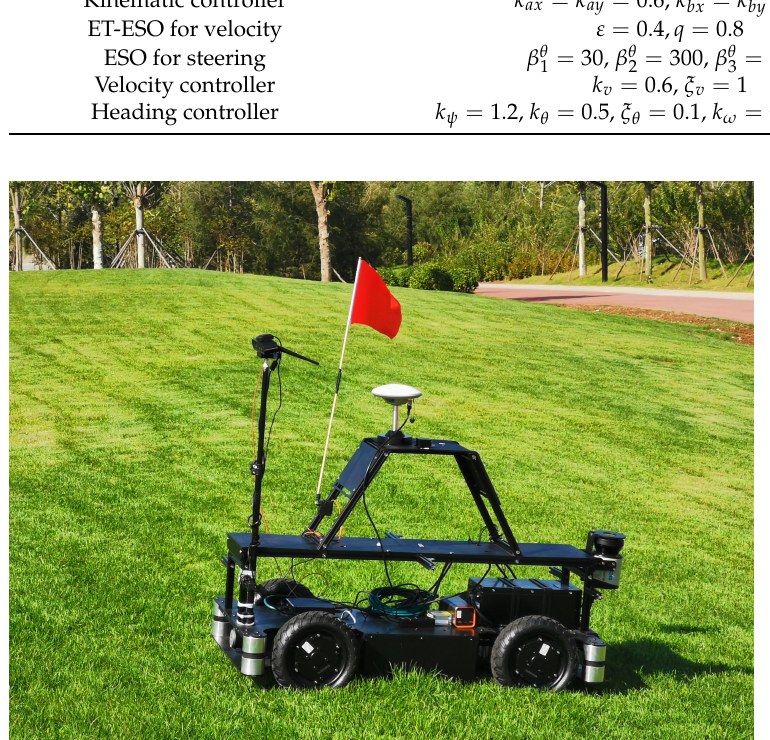
Figure 3. The CLMR and scene in practical